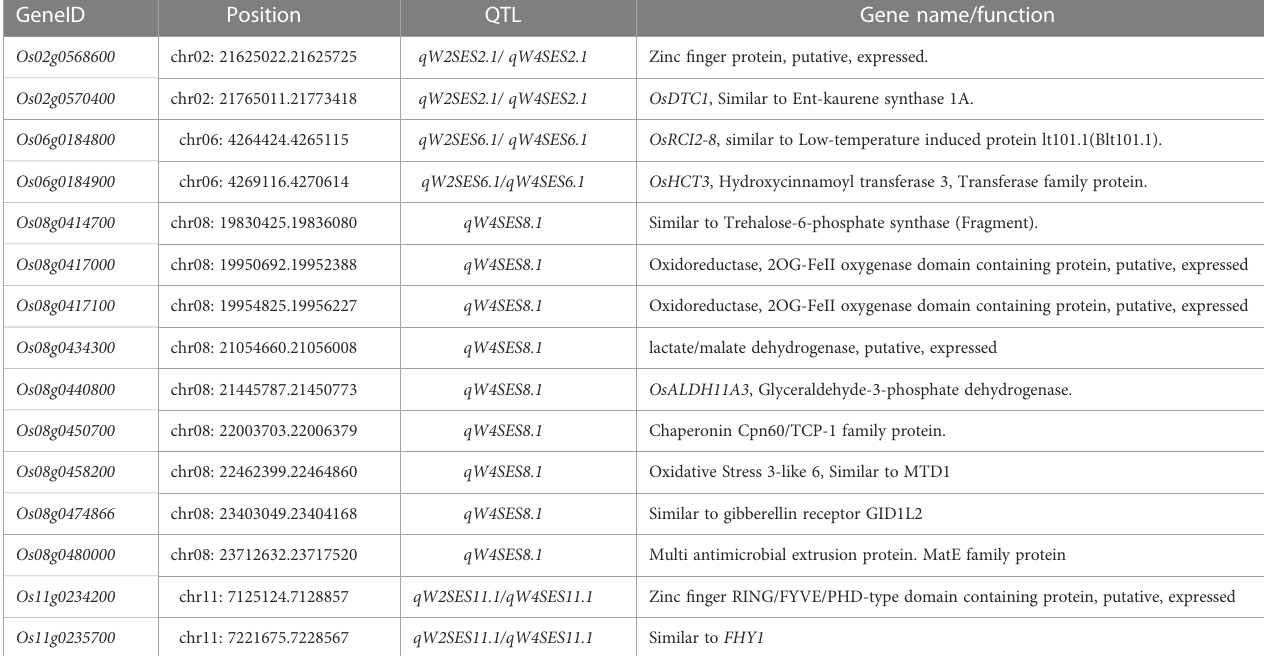
TABLE 6 The promising genes associated with salt tolerance.